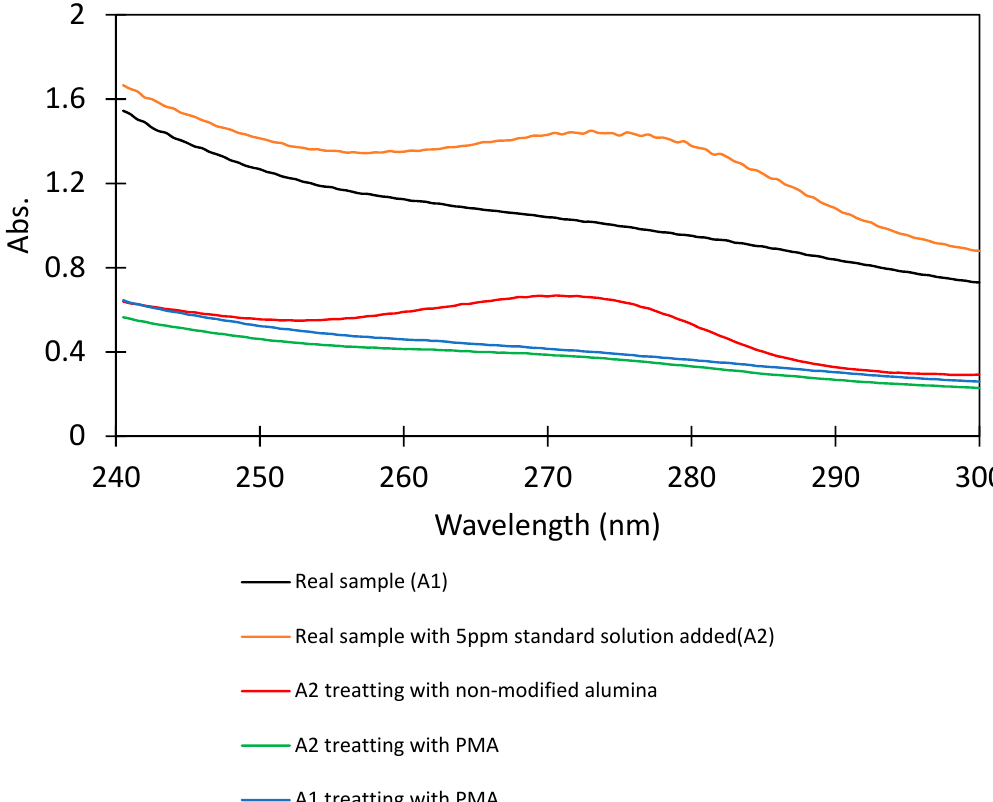
Figure 10. UV-Vis spectra of CFX in the hospital wastewater samples before and after treatment. The (A1) real sample and the (A2) real samples with 5 ppm of CFX standard solution added were treated using alumina and PMA. Baseline subtraction was conducted at the wavelength of CFX maximum absorbance, 272 nm.